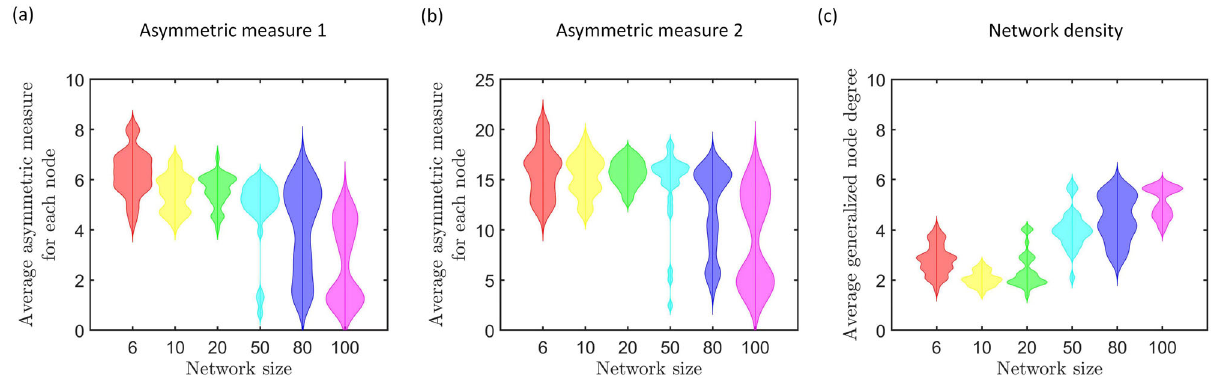
Fig. 6 The optimized network with directed 2-hyperlink interactions are structurally asymmetric in general. Synchronizability of networks with directed 2-hyperlink interactions is optimized by minimizing Eq. (21) with simulated annealing. The directed 2-hyperlink interactions are deleted, which allows to reach directed networks. a , b Violin distribution of the two asymmetric measures in Eq. (25), Eq. (26) for the optimized directed networks with various size 6, 10, 20, 50, 80, 100, as speci fi ed by the color. They show that the optimized network are generally asymmetric, as most of the 30 numerical replicates lead to nonzero asymmetric measures. Each numerical replicate has used the most synchronizable network optimized from 1000 different randomly initialized networks. c The network density as the averaged generalized nodes' degree in